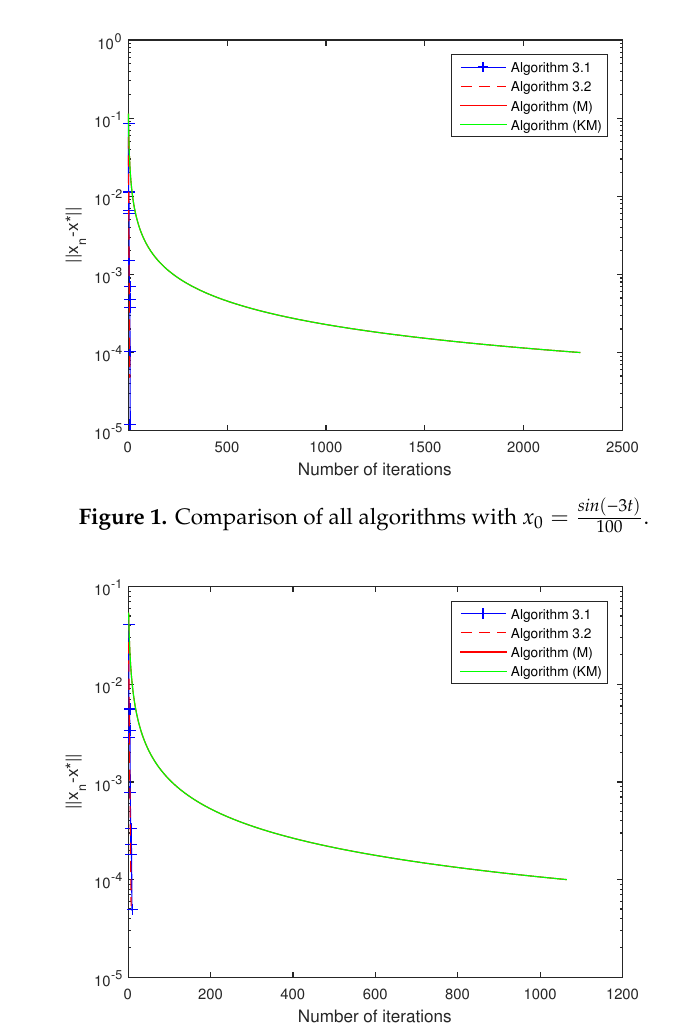
Figure 2. Comparison of all algorithms with x 0 =